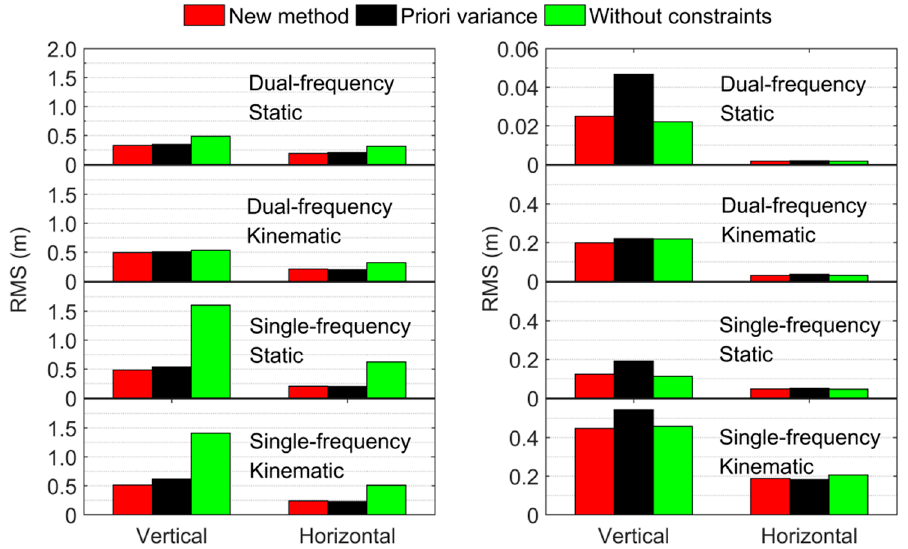
Figure 8. RMS statistics of positioning errors for different RT PPP processing methods at the beginning of 30 min ( left ) and all day ( right ).